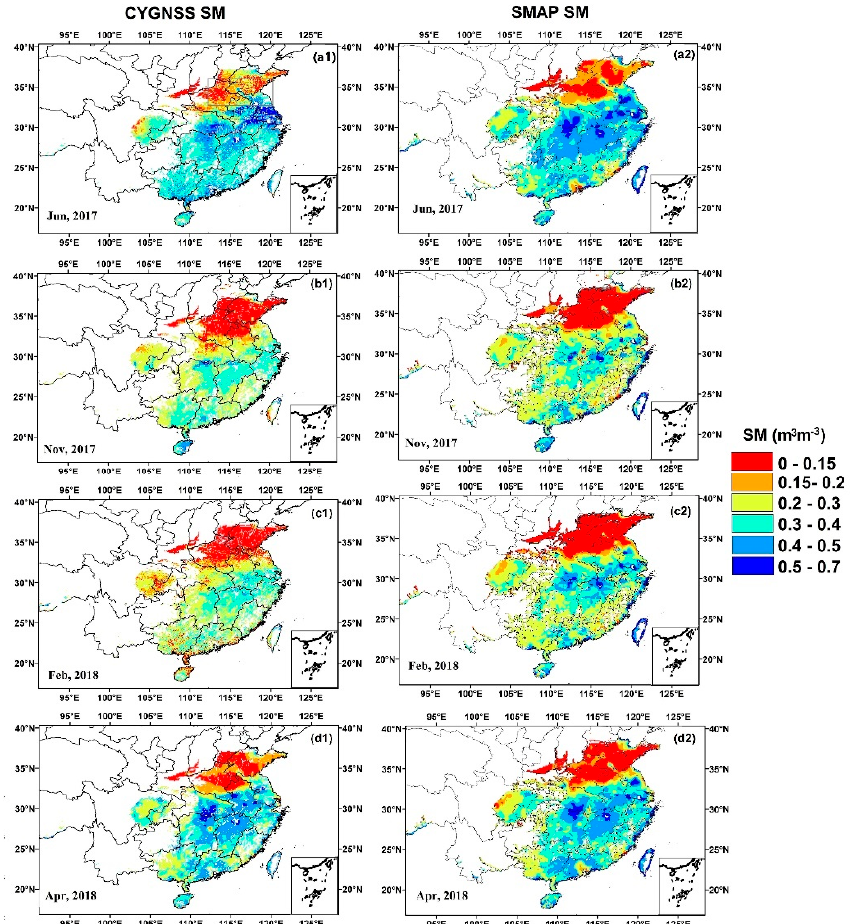
Figure 7. Comparisons of the SM derived from CYGNSS and the SMAP SM. ( a 1– a 2) June 2017, ( b 1– b 2) November 2017, ( c 1– c 2) February 2017, and ( d 1– d 2) April 2018.